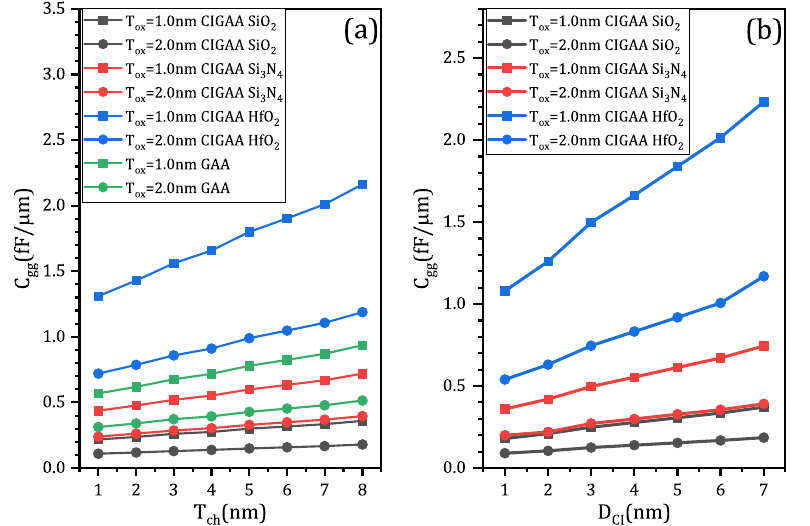
Figure 11. Gate capacitance dependence on: ( a ) channel thickness; ( b ) the Core–Insulator diameter D CI